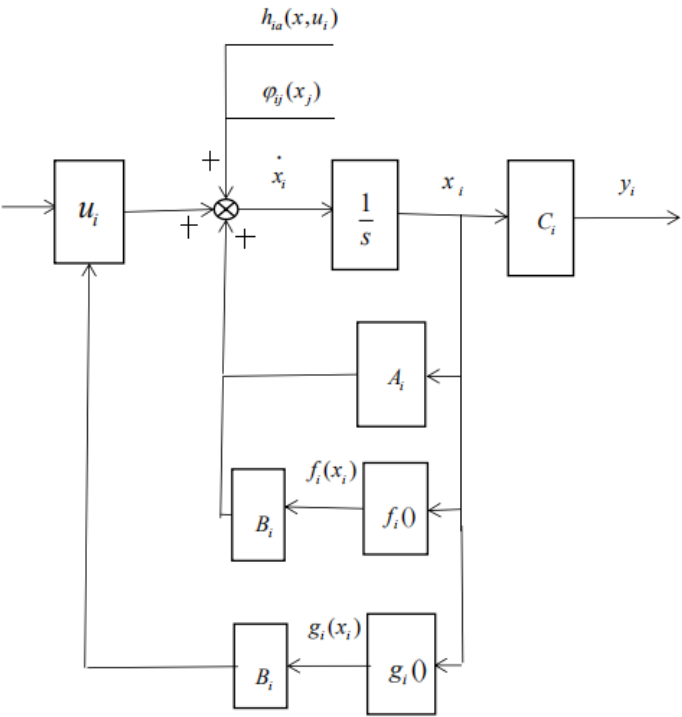
Figure 1. Block diagram of the state equation of the subsystem. In Figure 1, f i () and g i () represent nonlinear functions of x i